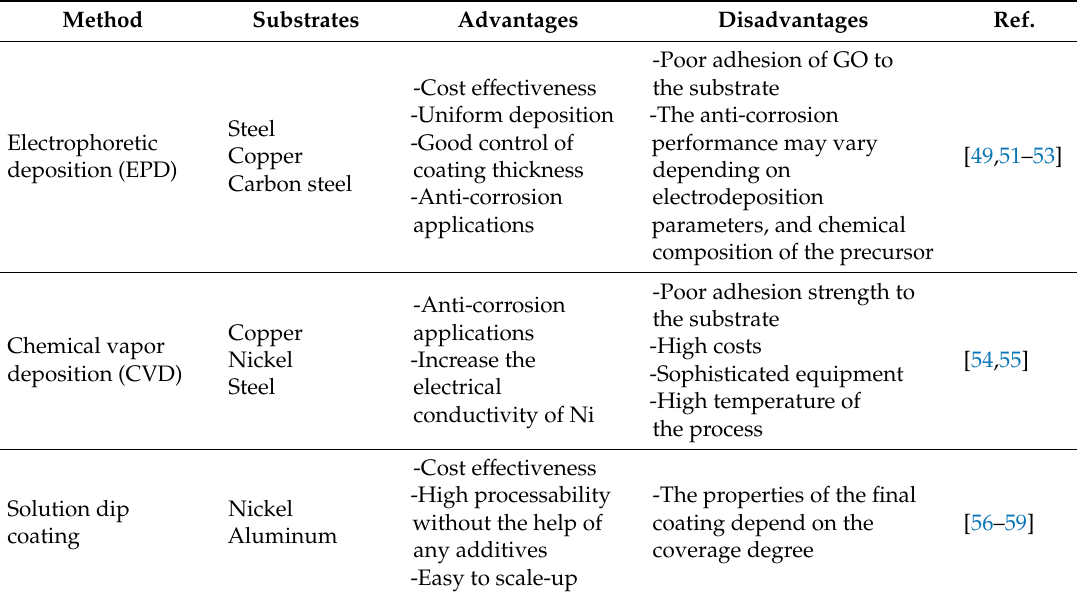
Table 1. Pure graphene coatings for corrosion